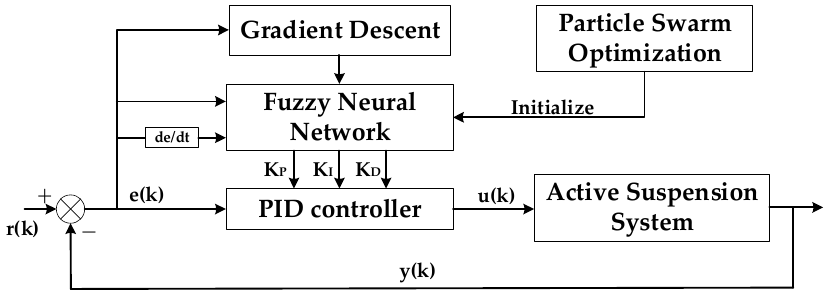
Figure 2. FNN-PID controller structure model.